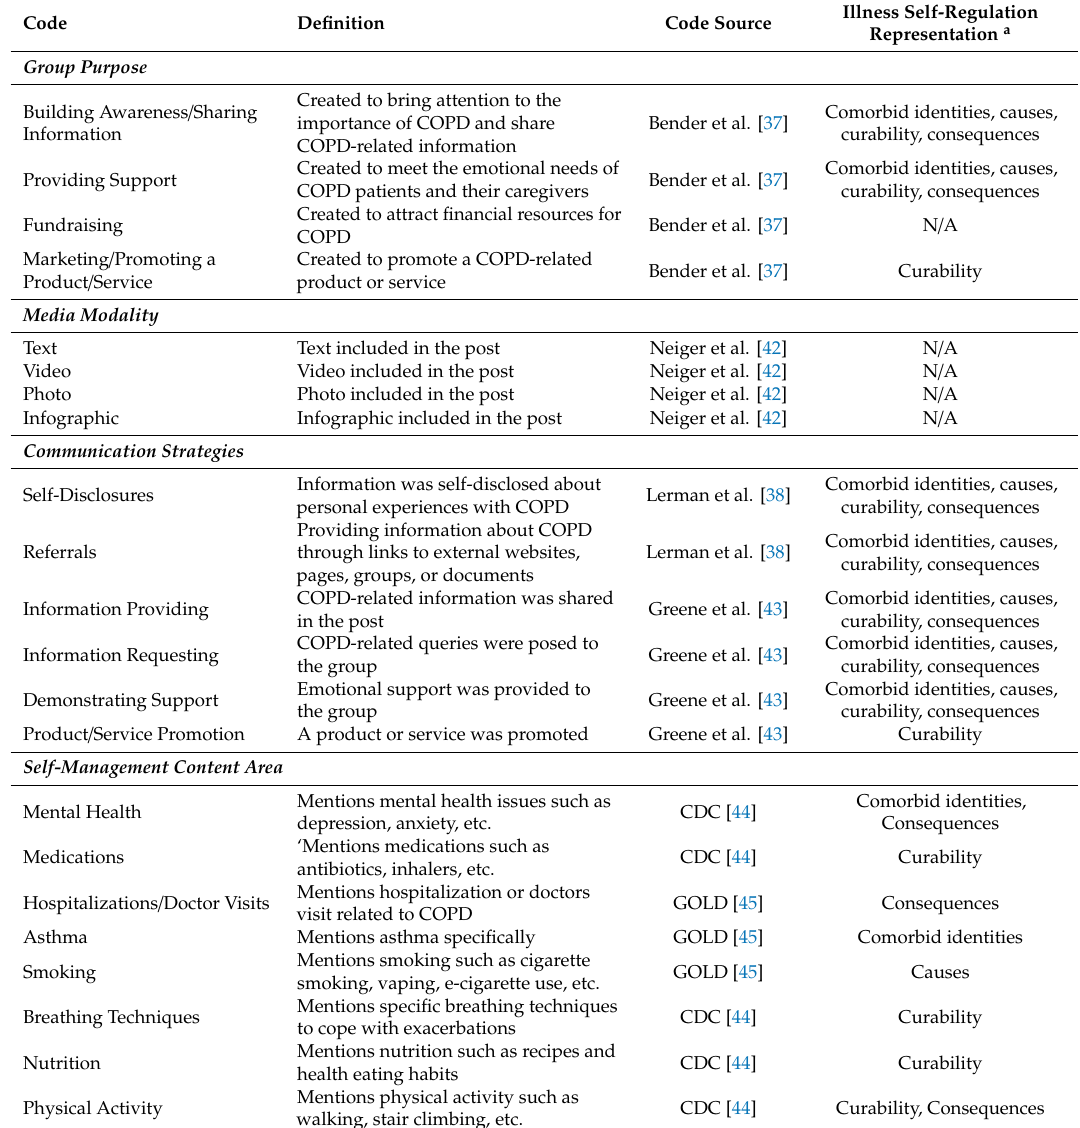
Table 1. Facebook group content analysis codes, definitions, and code